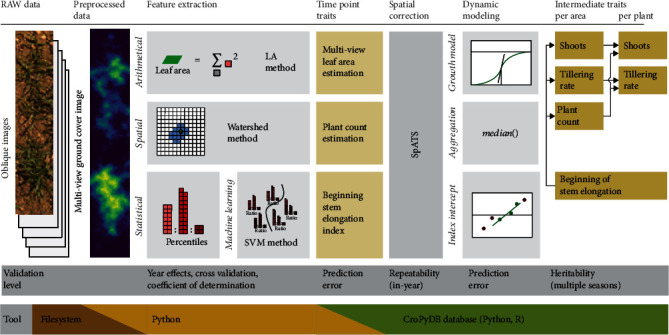
Phenotyping strategy including preprocessing, feature extraction, time point traits, spatial correction, dynamic modeling, and finally intermediate level traits. Graphs represent exemplary visualizations of the applied methods (LA: apparent leaf area; SVM: support vector machine).